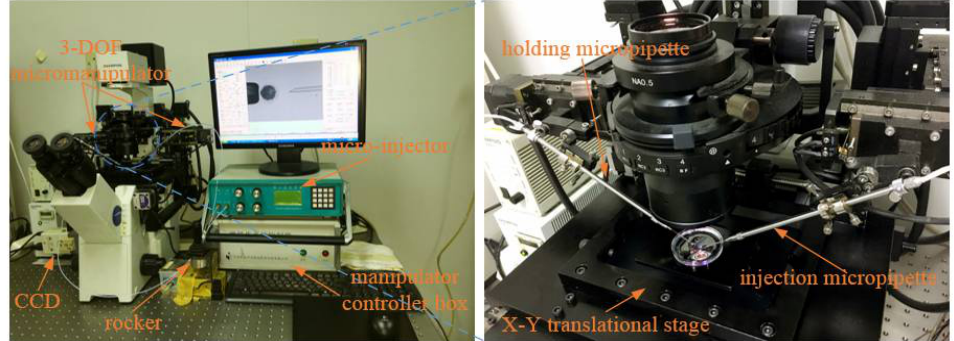
Figure 7. The NK-XMR160 micromanipulation system.